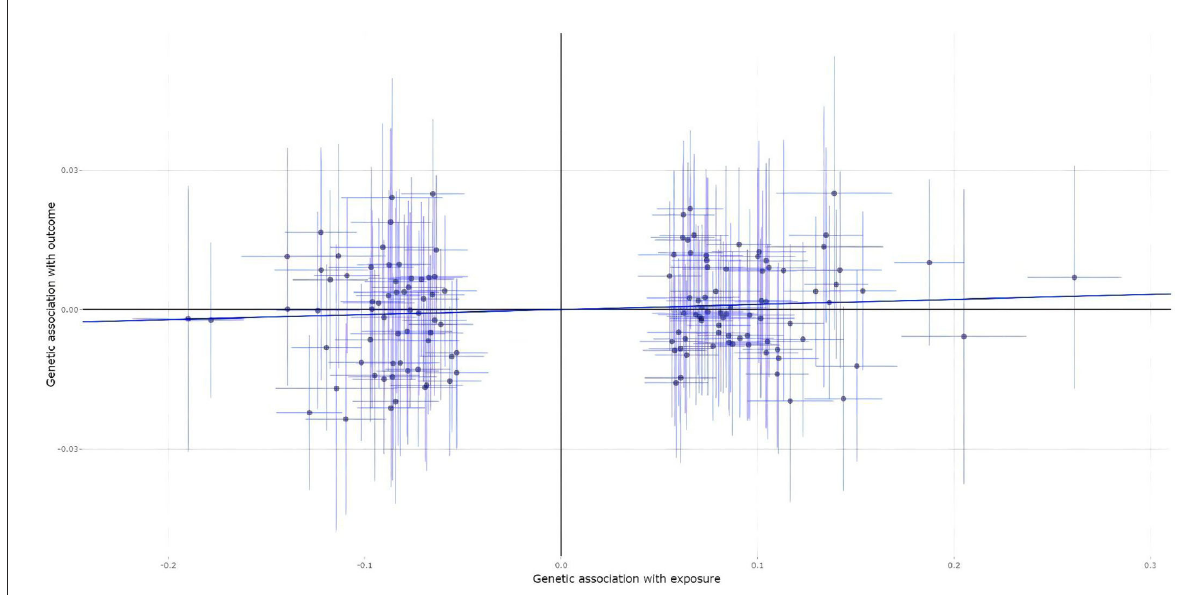
FIGURE4 The scatter plot for the MR analysis showing the causal estimates of MS on fracture using the IVW method.